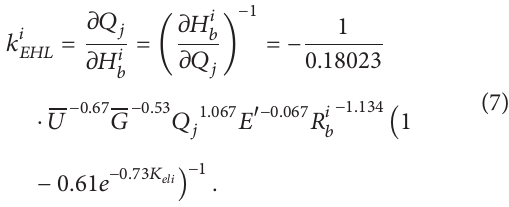
where 𝑈 = 𝜇 𝑏 𝑢/2𝐸 󸀠 𝑅 𝑏 is a nondimensional velocity, 𝐺 = 𝛼𝐸 󸀠 is a nondimensional material parameter, 𝑊 = 𝑄 𝑏 /𝐸 󸀠 𝑅 2 𝑏 is a nondimensional load parameter, 𝑒 𝑏 is the ellipticity of the rolling element, 𝜇 𝑏 is the dynamic viscosity, 𝑢 is the